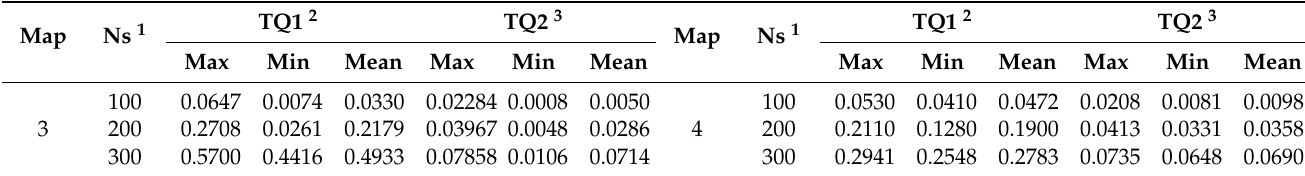
Table 4. Parameters of different query process in the multi-channel